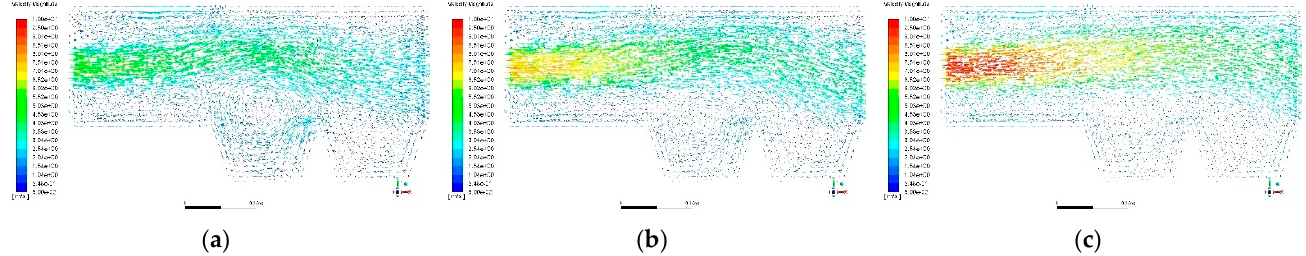
Figure 4. Wind field with different outlet wind speed: ( a ) v = 5 m·s − 1 ; ( b ) v = 7 m·s − 1 ; ( c ) v = 9 m·s − 1 .